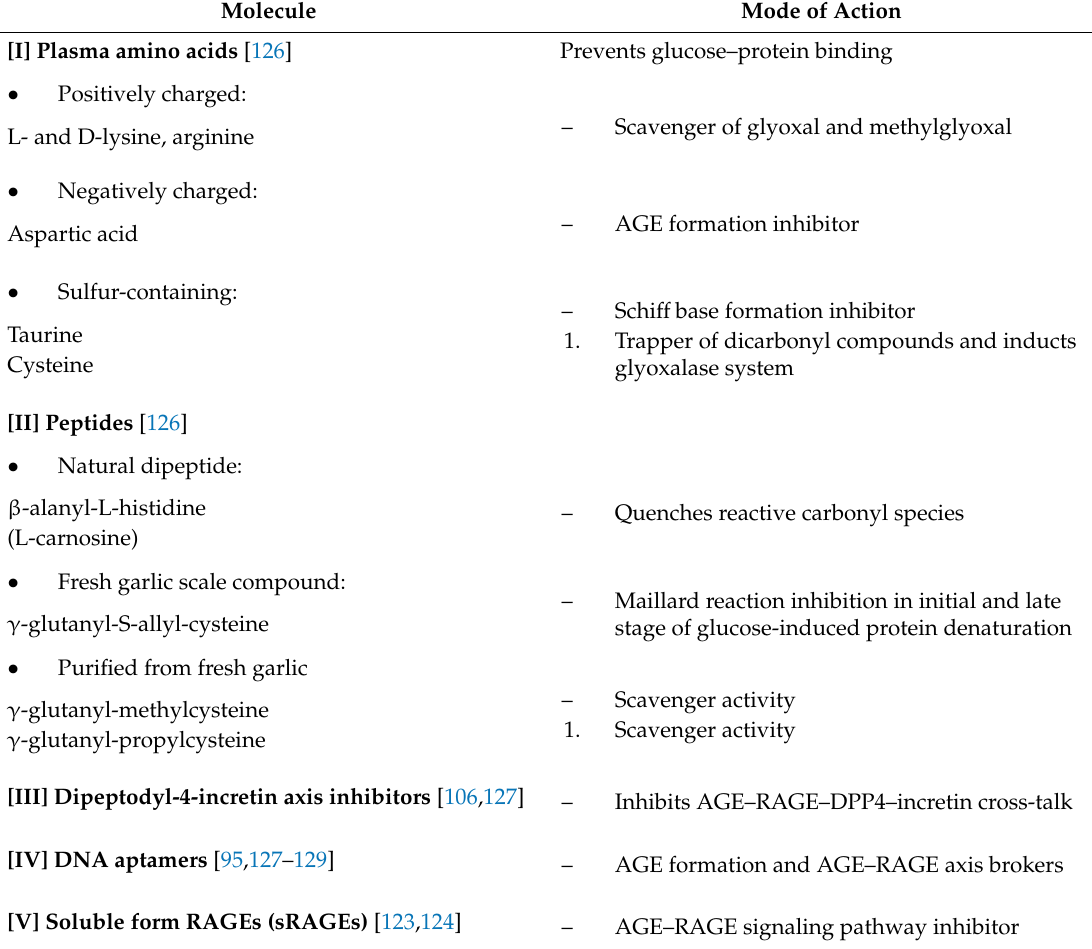
Table 2. Biomolecules and phytochemicals acting as inhibitors of Maillard reaction and AGE–RAGE signaling in treatment of AGE-related